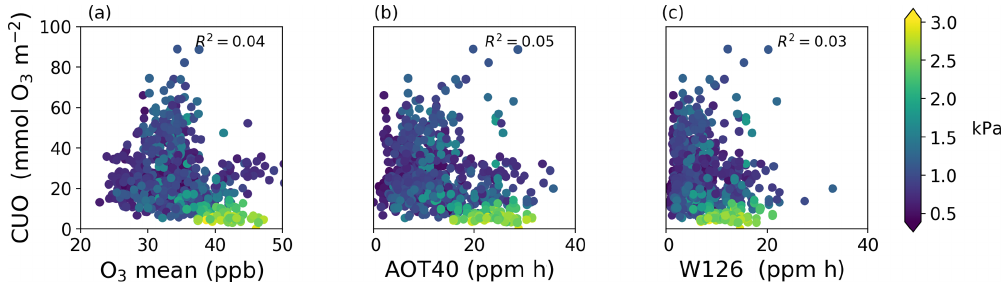
Figure 6. Comparison of cumulative uptake of O 3 (CUO) to concentration-based metrics of O 3 exposure during the daytime growing season at 103 sites: mean O 3 concentration (a) , AOT40 (center), and W126 (b) . There is one value (dot) per site per year. Colors show mean vapor pressure deficit during the growing